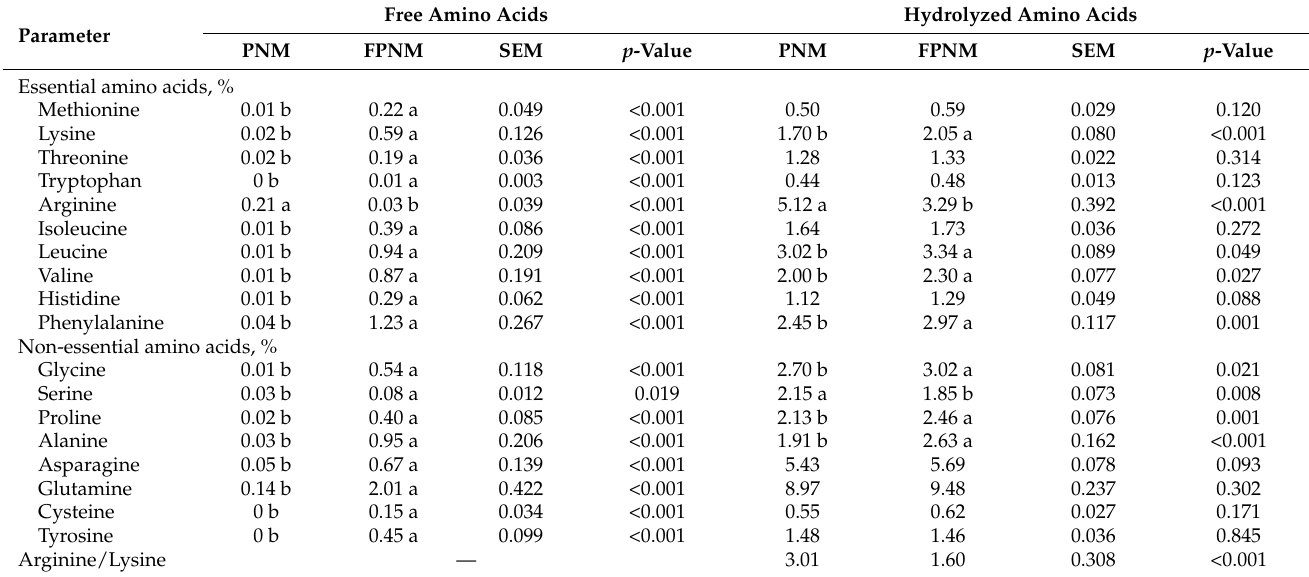
Table 4. Effects of solid-state fermentation on the amino acids of PNM and FPNM (dry matter basis, n = 3) 1 .